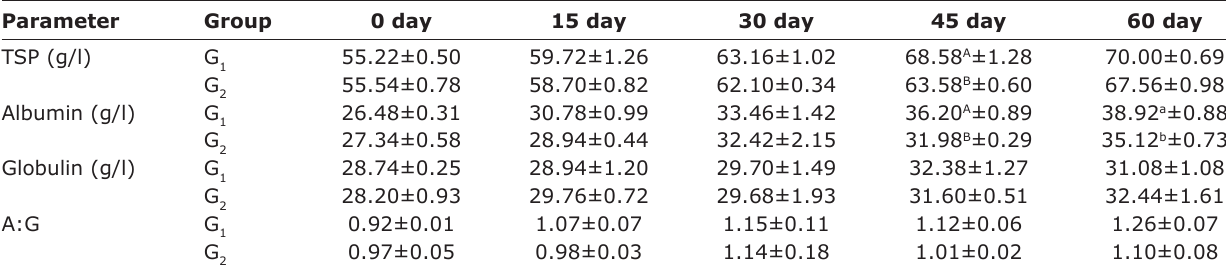
Table-3: Mean±SE of serum biochemical parameters of Vrindavani calves at fortnightly interval. Parameter Group